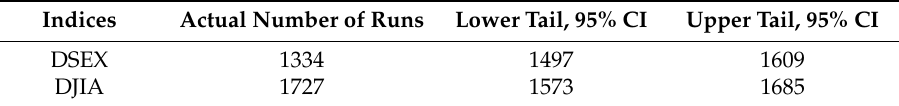
Table 3. Statistical Independence of Index